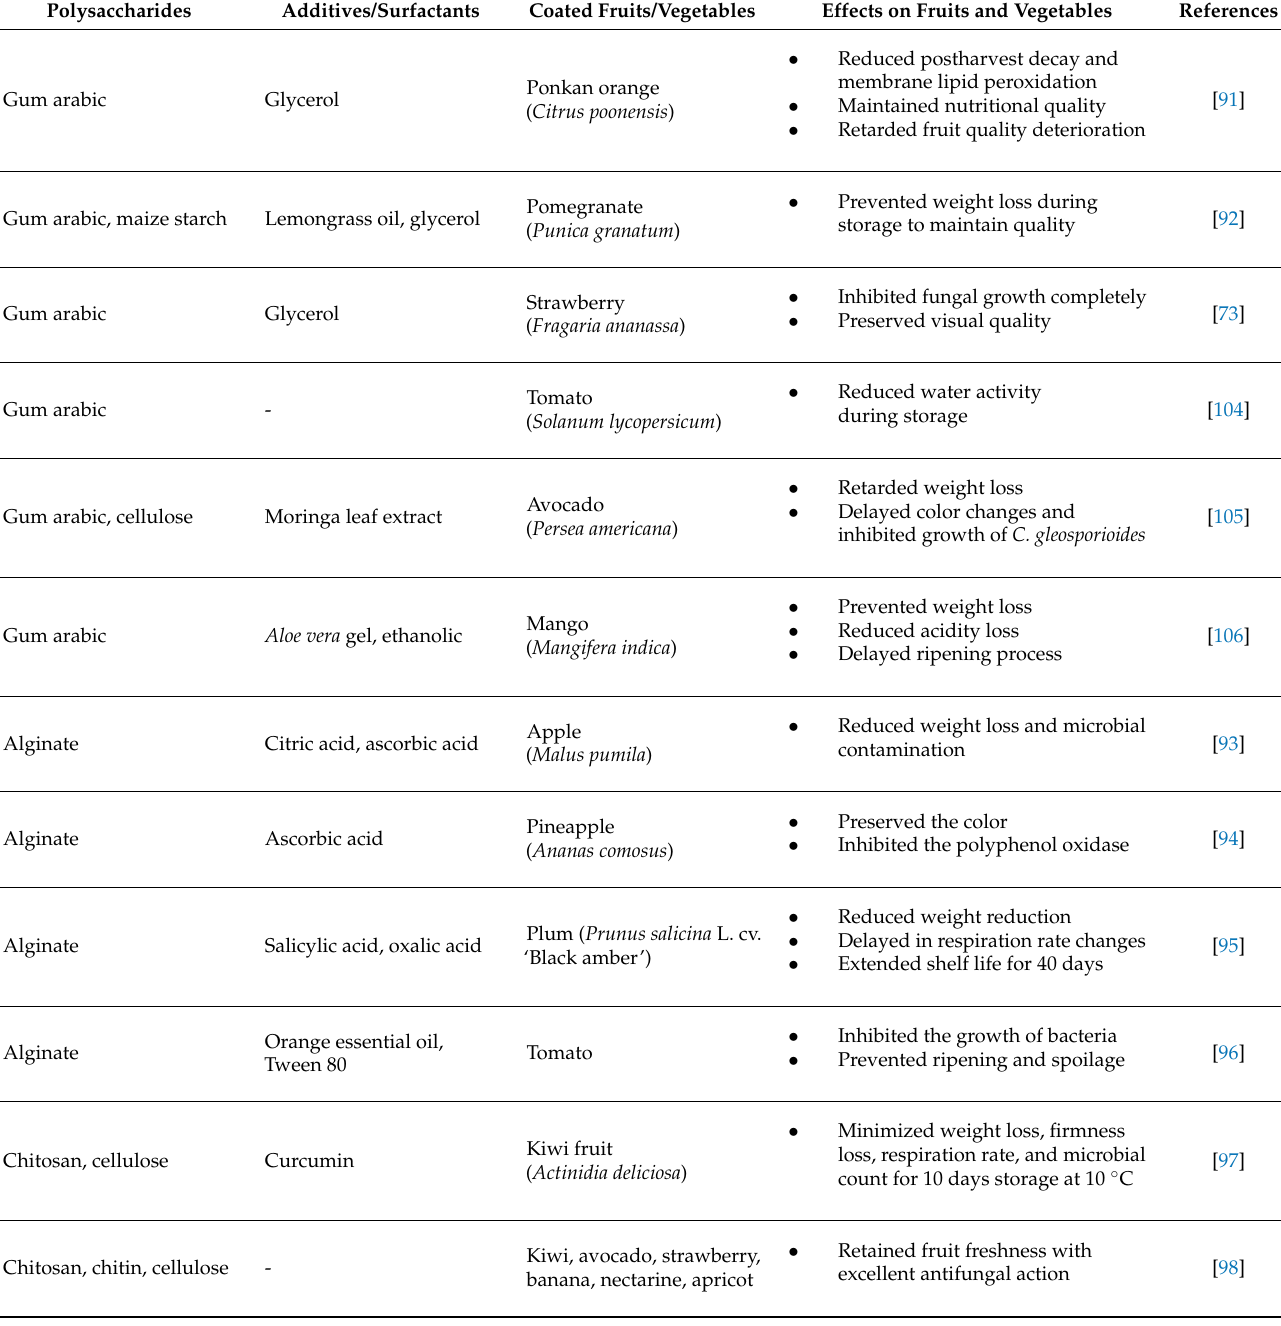
Table 1. Examples of polysaccharide coatings employed to enhance the quality of various fruits and